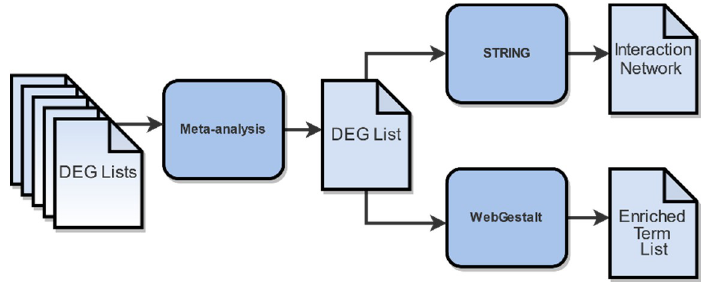
Figure 4. Functional enrichment analysis workflow. Differential Gene Expression Analysis (DGEA)-derived genes, subdued to meta-analysis, yielded the final DEGs of utmost statistical significance. Inputting these DEGs into WebGestalt and STRING generated the resulting enriched terms and PPI network, respectively. Supplementary Materials: Supplementary materials can be found at www.mdpi.com/xxx/s1.